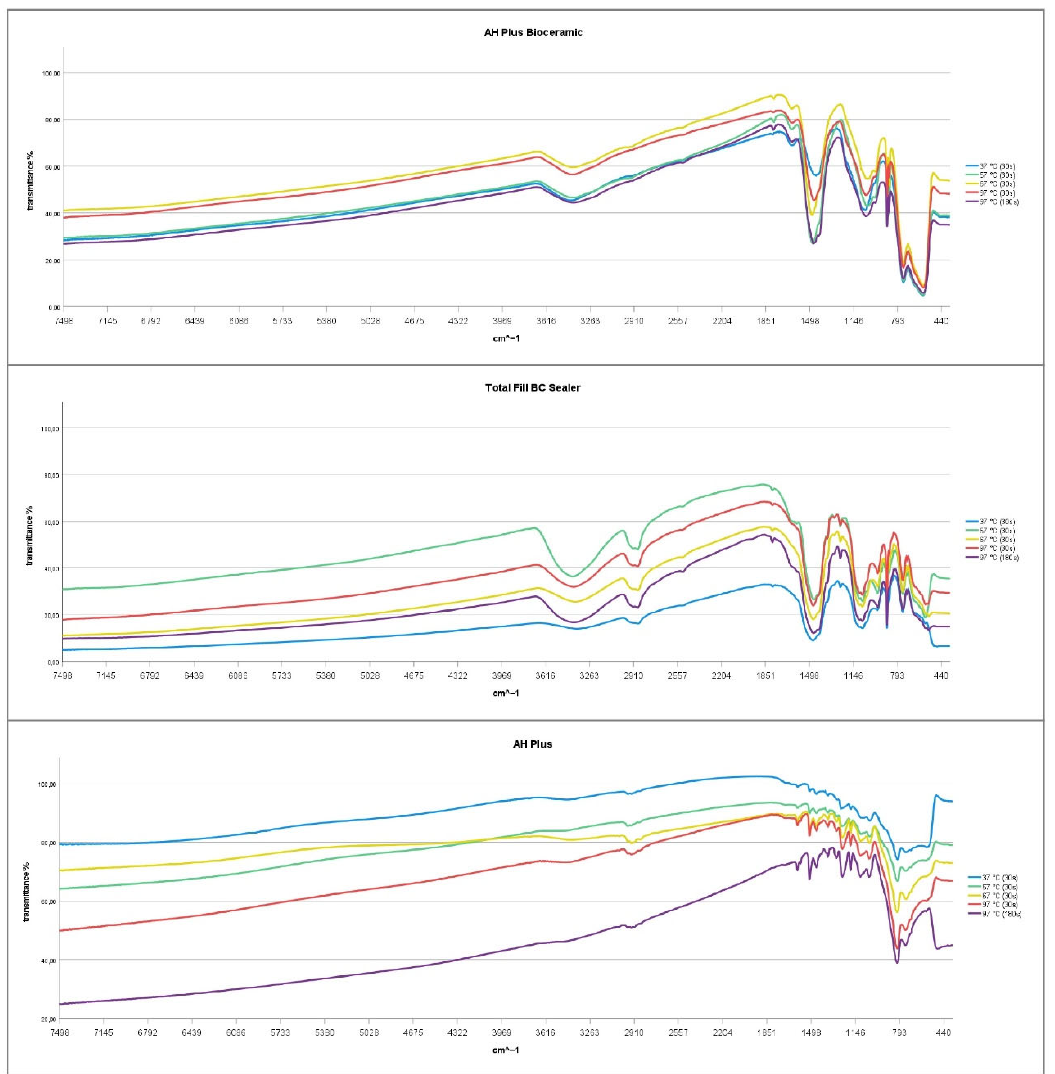
Figure 2. Spectroscopic plots of FT ‐ IR spectroscopy after thermal treatment of AHBC, TFBC, and AHP .